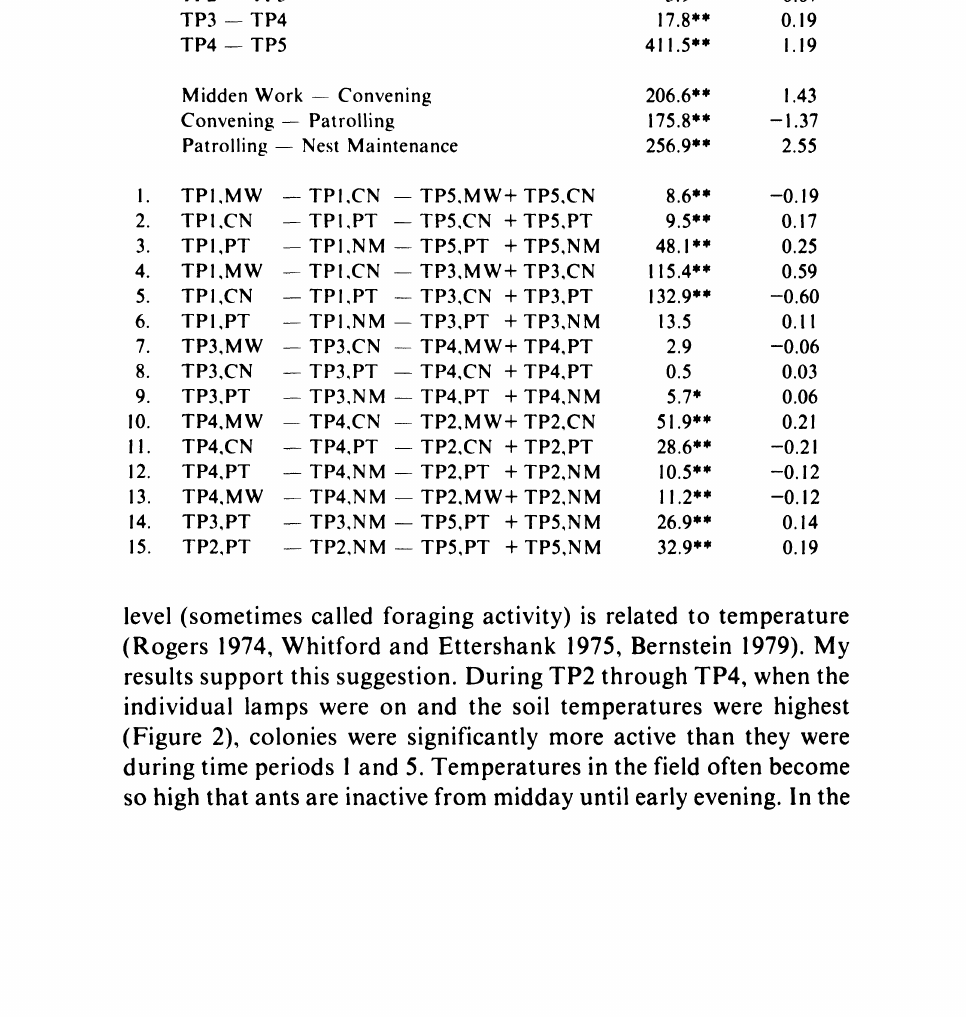
Table 2. Results of profile analysis. Results of test for differences in activity level by time period are shown at the top of the table; for test for differences in number of ants in each activity, middle of the table; for test for activity-time period differences (parallelism test), bottom of the table. Data are log-transformed. Symbols used are ** p > 0.01; *, p > 0.05; #, marginal significance. TP time period;